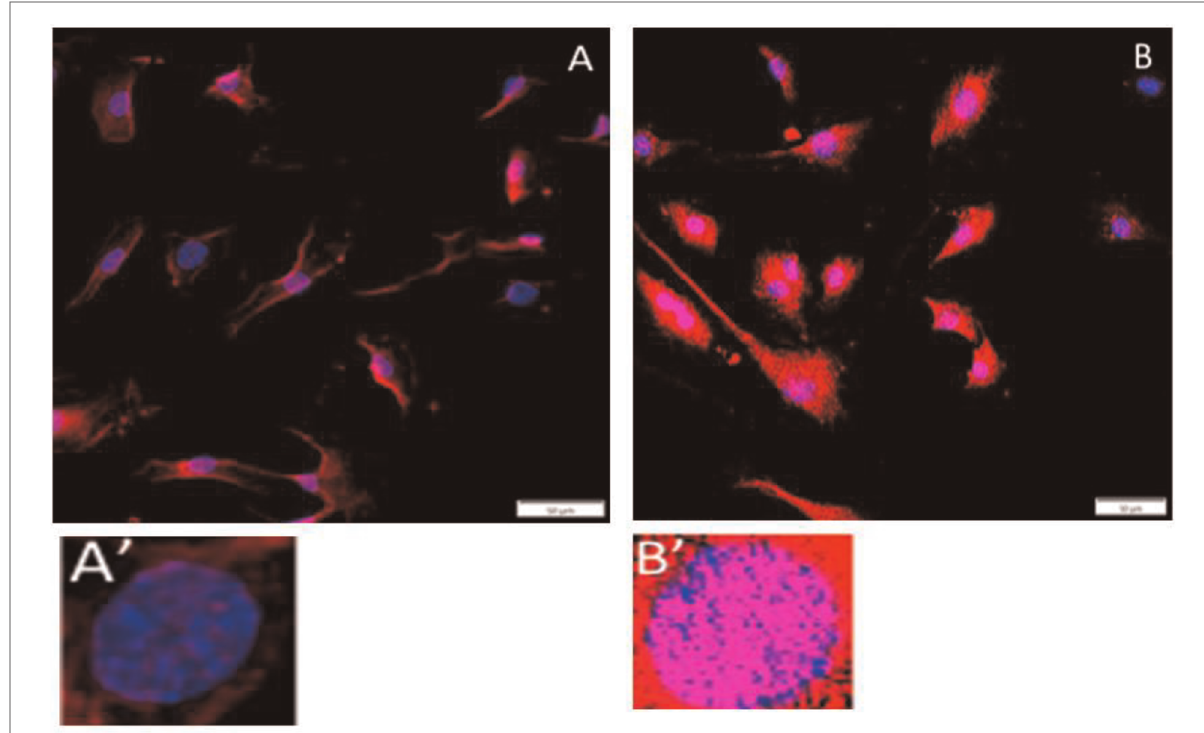
FIGURE 5 In-vitro nuclear expression of stem cell or de-differentiation markers. In fi gure, gingival fi broblast-like cells from normal B6 female mice were grown on coverslips, treated without ( A,A' ) or with 1,4-DPCA (100 uM) ( B,B' ) overnight in culture, and stained with antibody to OCT3/4 (red) and the nuclei stained with DAPI (blue). OCT3/4 staining is seen in the cytoplasm in DPCA-untreated cells and seen increased in the cytoplasm but now also found in the nucleus in DPCA-treated cells. The scale bars =